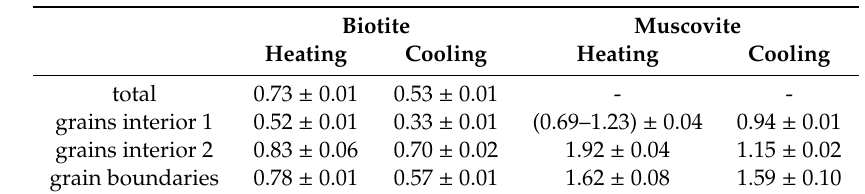
Table 2. Activation energies ( E a ) of Arrhenius type behavior of dc-conductivity (straight lines in Figure 4) during heating and subsequent cooling of biotite and muscovite mica samples. All values are in eV. Error values are derived from the fittings.